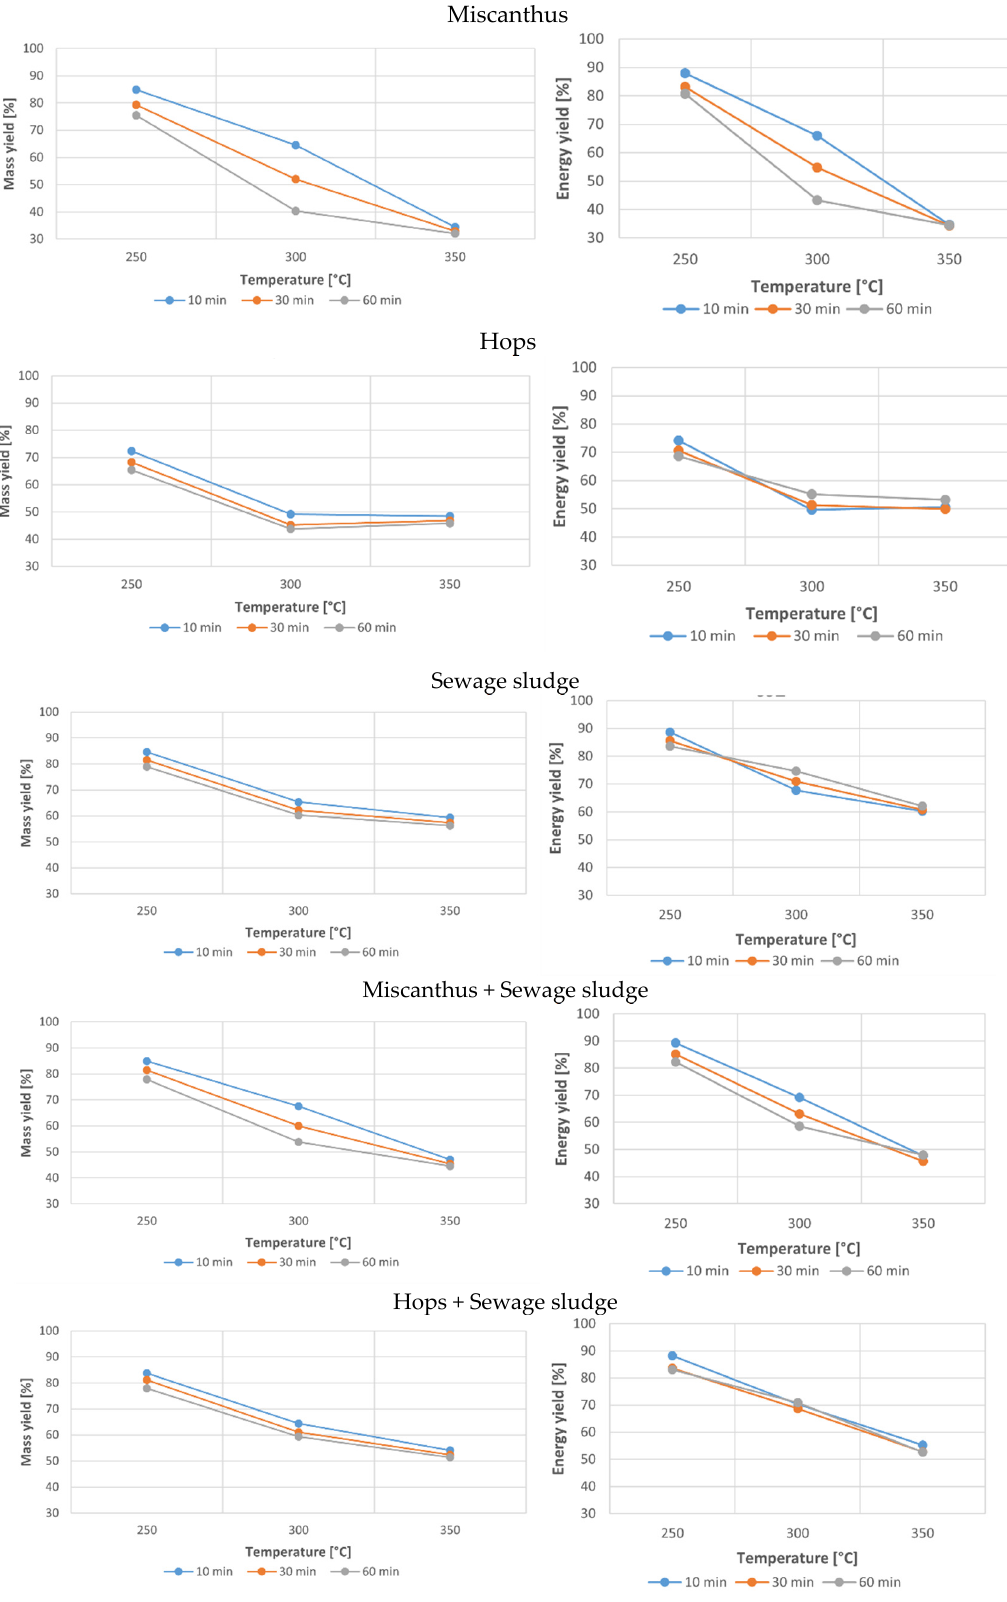
Figure 3. Mass yield and energy yield with respect to torrefaction temperature and time for all five materials. Table 4. HHV (MJ/kg) and EMCI of studied biomasses with respect to temperature and time. Material T (°C)